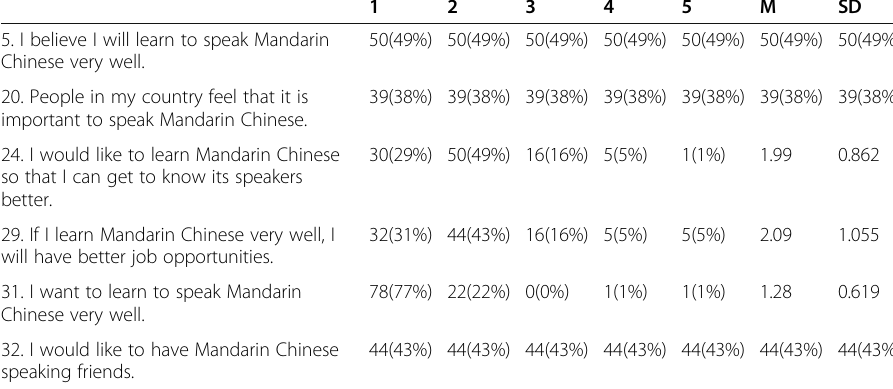
Table 5 Frequency of Participant Response to BALLI items on Learner Motivation and Expectation 1 2 3 4 5 M